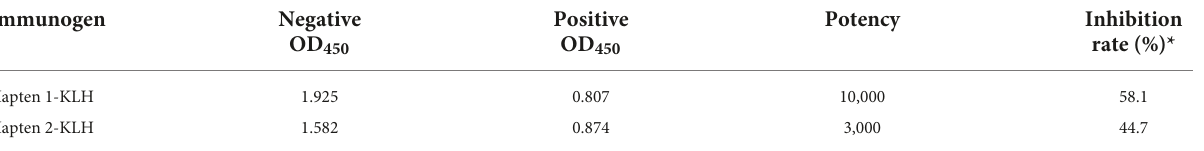
TABLE 1 Results for mouse antiserum.